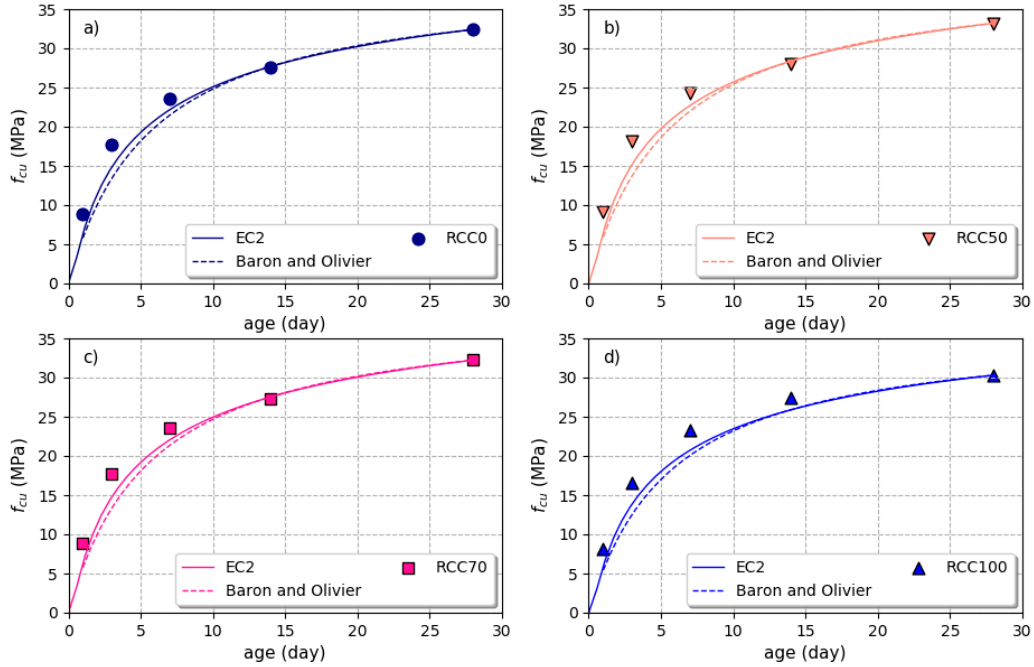
Table 3. Correlation factors between experimental results and prediction models.